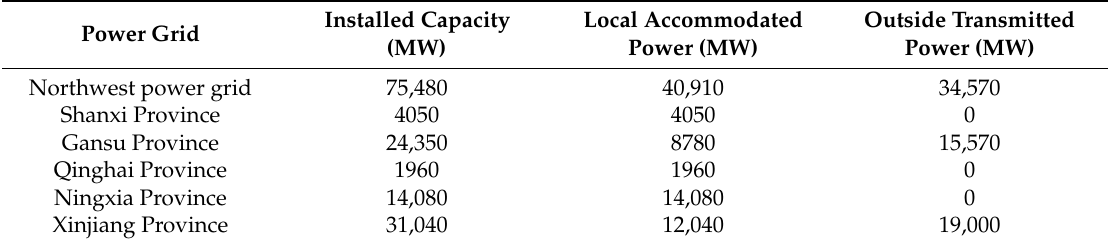
Table 2. Wind power accommodation in the Northwest power gird.